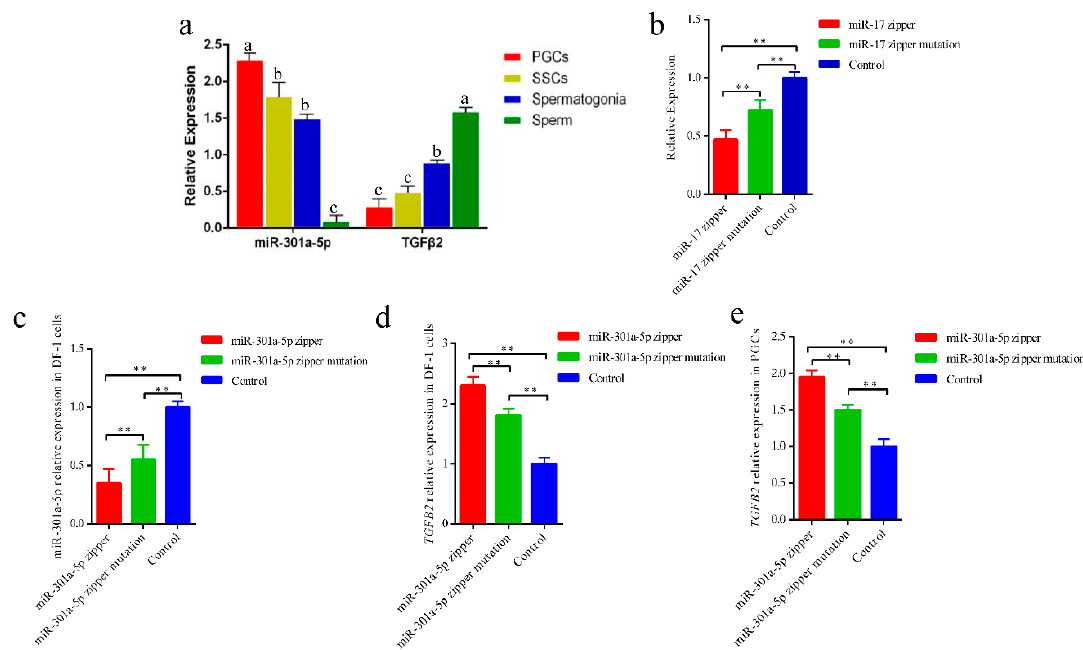
Figure 2. miR-301a-5p may affect TGFB2 expression in DF-1 and PGCs. ( a ) miR-301a-5p and TGFB2 expression during spermatogenesis; ( b ) quantitative real-time PCR analysis showing the decreased level of miR-17 in DF-1 after transfection of the miR-17 zipper and miR-17 zipper mutation; ( c ) quantitative real-time PCR analysis showing the decreased level of miR-301a-5p in DF-1 after transfection of the miR-301a-5p zipper and miR-301a-5p zipper mutation; ( d , e ) expression analysis showing the TGFB2 change in DF-1 and PGCs after transfection of the miR-301a-5p zipper and miR-301a-5p zipper mutation. Data shown as mean ± SEM, ** p < 0.01. Different letters indicate statistically significant differences at p < 0.05.